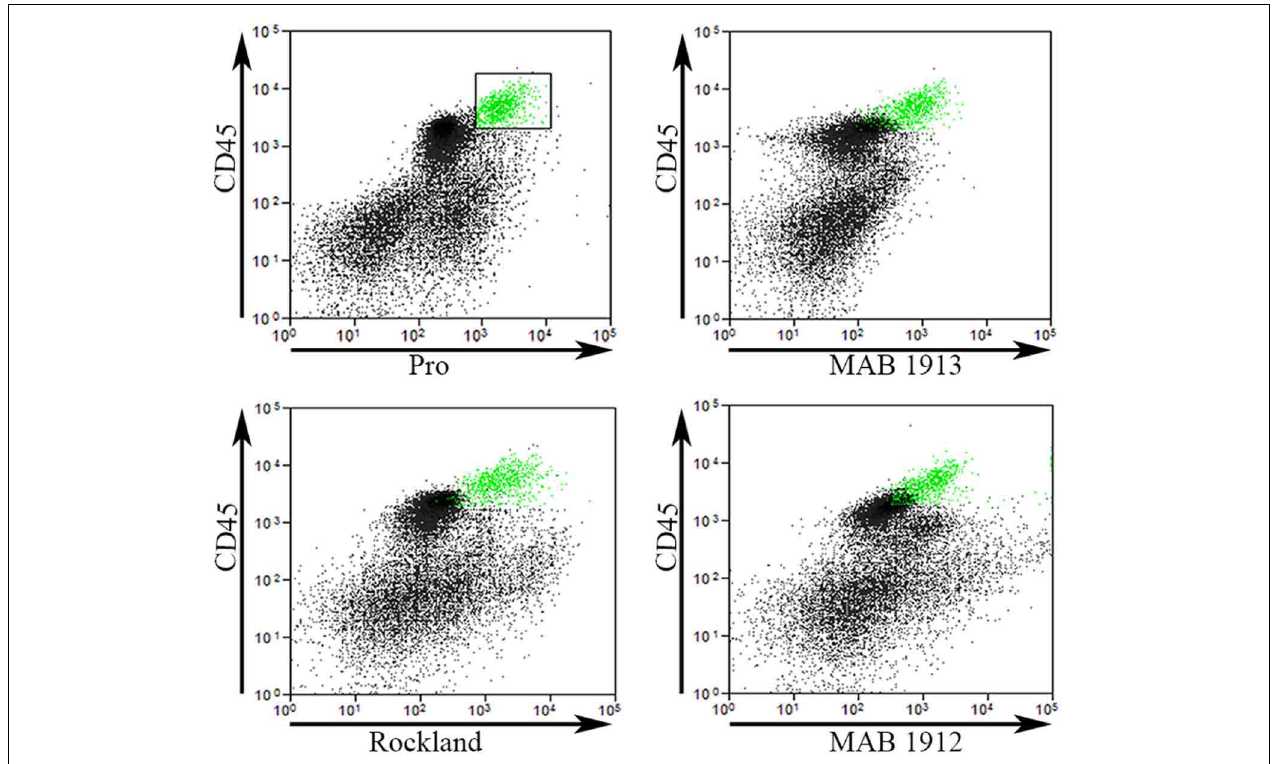
FIGURE 5 | Comparison of Pro to other collagen antibodies. Total lung cells from a bleomycin-treated mouse sacrificed 28 days after initiation of treatment were immunolabeled for CD45, Pro, and one of MAB1913, MAB1912, or Rockland. In the upper left panel, a scatter plot is shown with CD45 on the y-axis, Pro-on the x-axis, and a box containing Regions I and II with the cells inside the box selected and marked in green. In the other three panels, scatter plots are shown with CD45 on the y-axis and, as indicated,